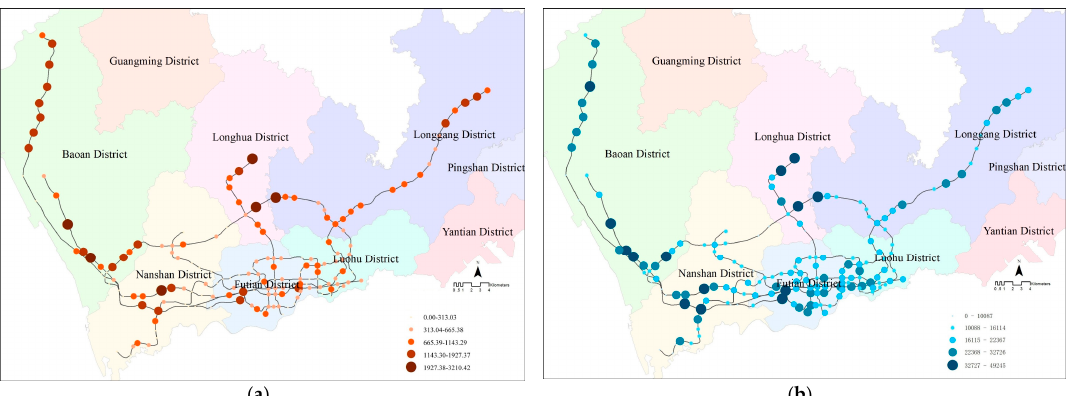
Figure 5. ( a ) Cycling accessibility in each metro station; ( b ) number of bicycle-metro trips in each Figure 5. (a) Cycling accessibility in each metro station; (b) number of bicycle-metro trips in each metro metro station.